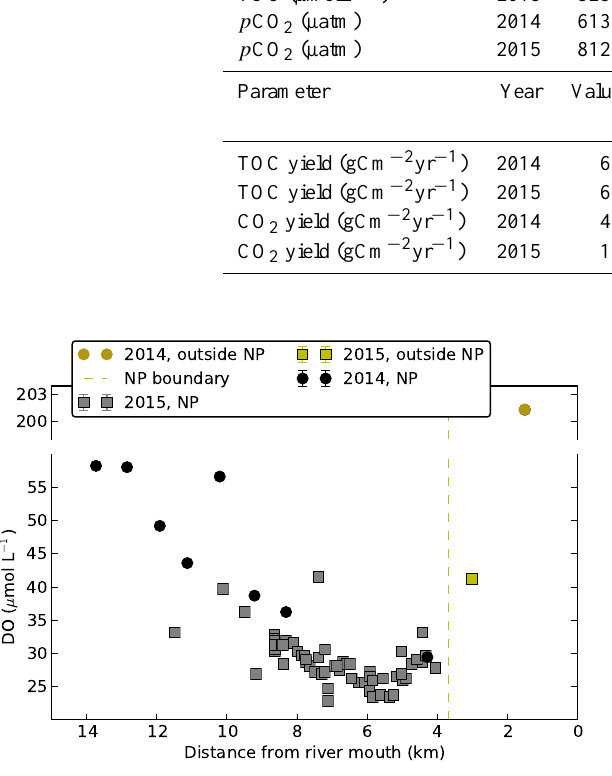
Figure 3. Dissolved oxygen concentrations in the Maludam River. Flow direction is from left to right. Note the discontinuous vertical axis. The yellow markers to the right of the dashed line refer to sampling stations outside the national